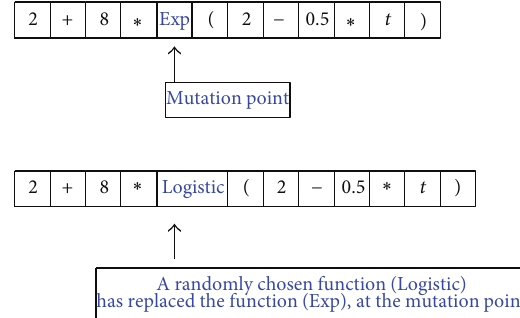
Figure 7: Mutation of the modified-hybrid Genetic Programming method (string